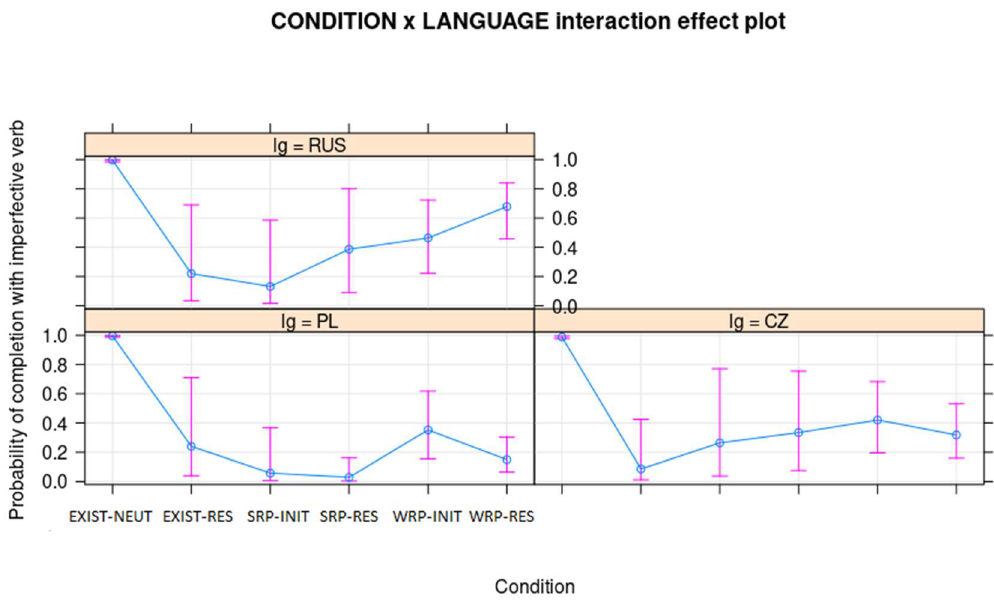
Figure 7. Language and condition plot.